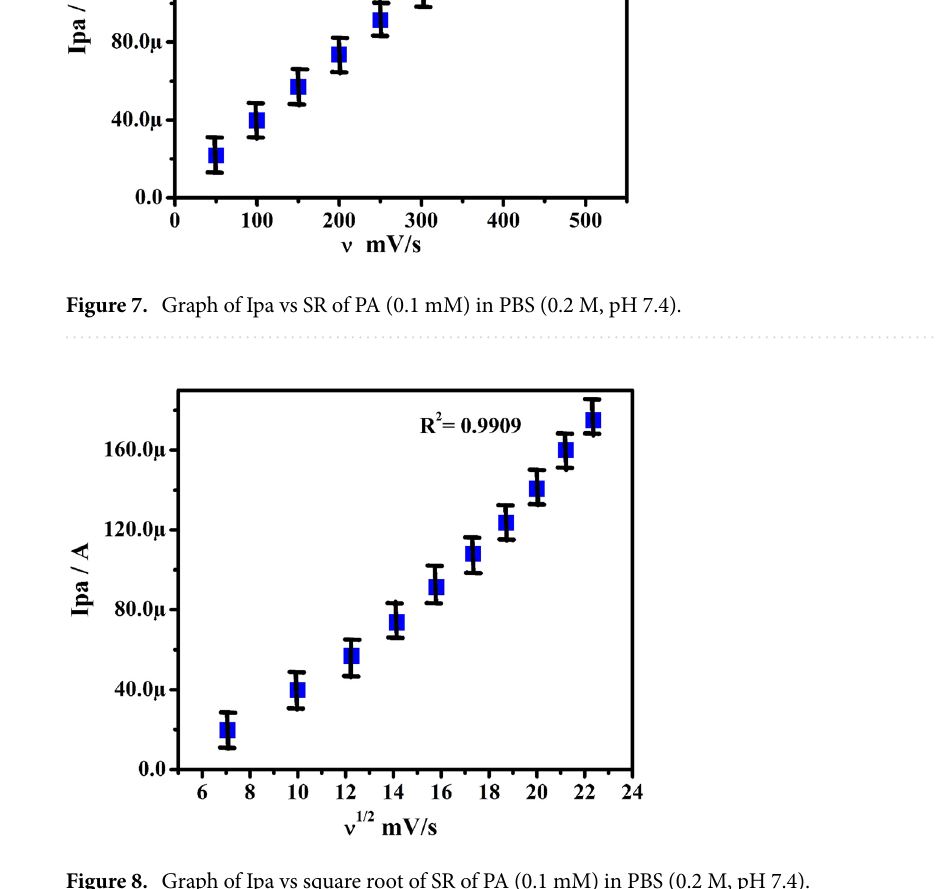
Figure 8. Graph of Ipa vs square root of SR of PA (0.1 mM) in PBS (0.2 M, pH